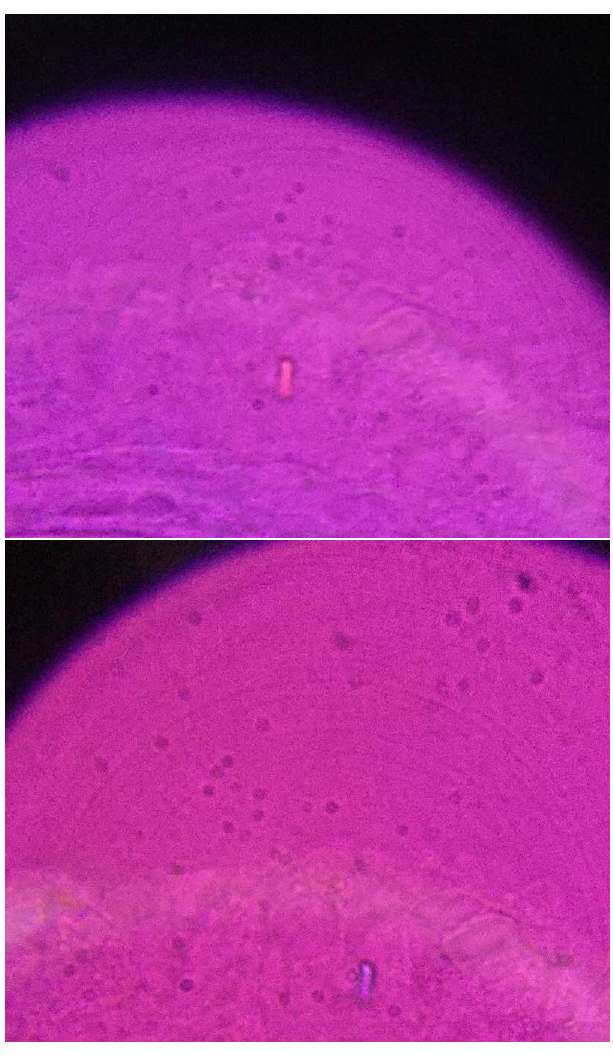
Figure 5 . The Birefringence Test of the Synovial Aspirate was Examined under Compensated Polarizing Light Microscopy with a Red Filter. Examination Shows a Rhomboid